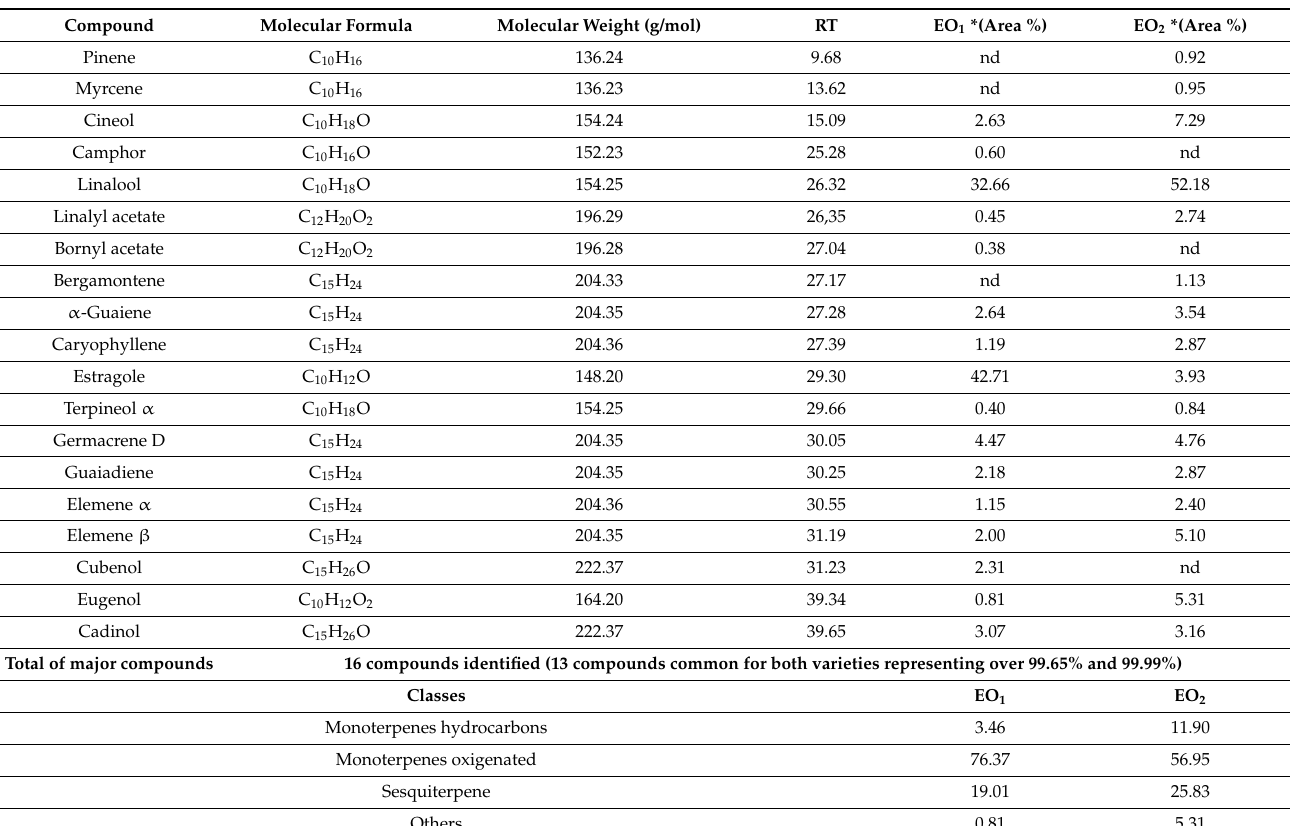
Table 2. Chemical composition of the EOs isolated from aerial plant part of the basil ( Ocimum basilicum L., fam. Lamiaceae